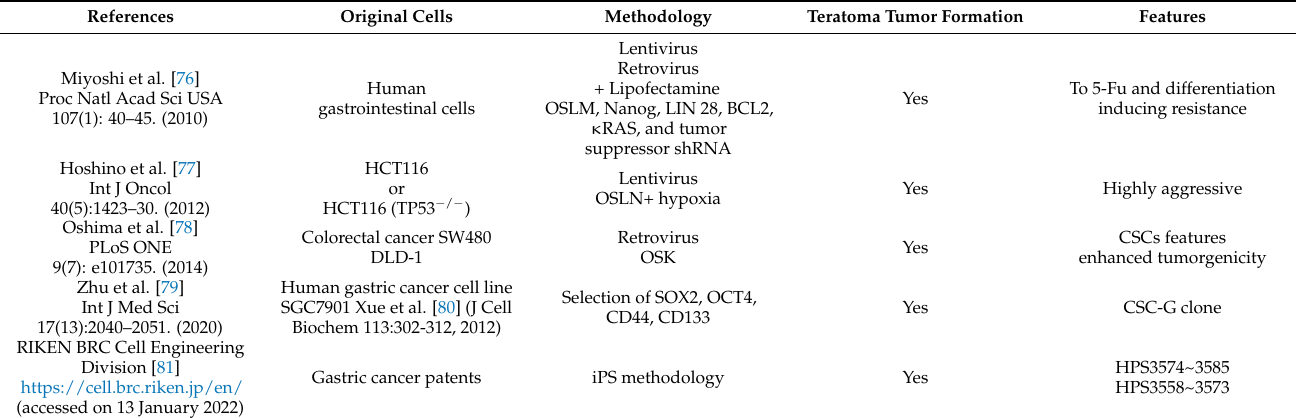
Table 2. Driver mutation of marker genes of CSCs in development of gastric